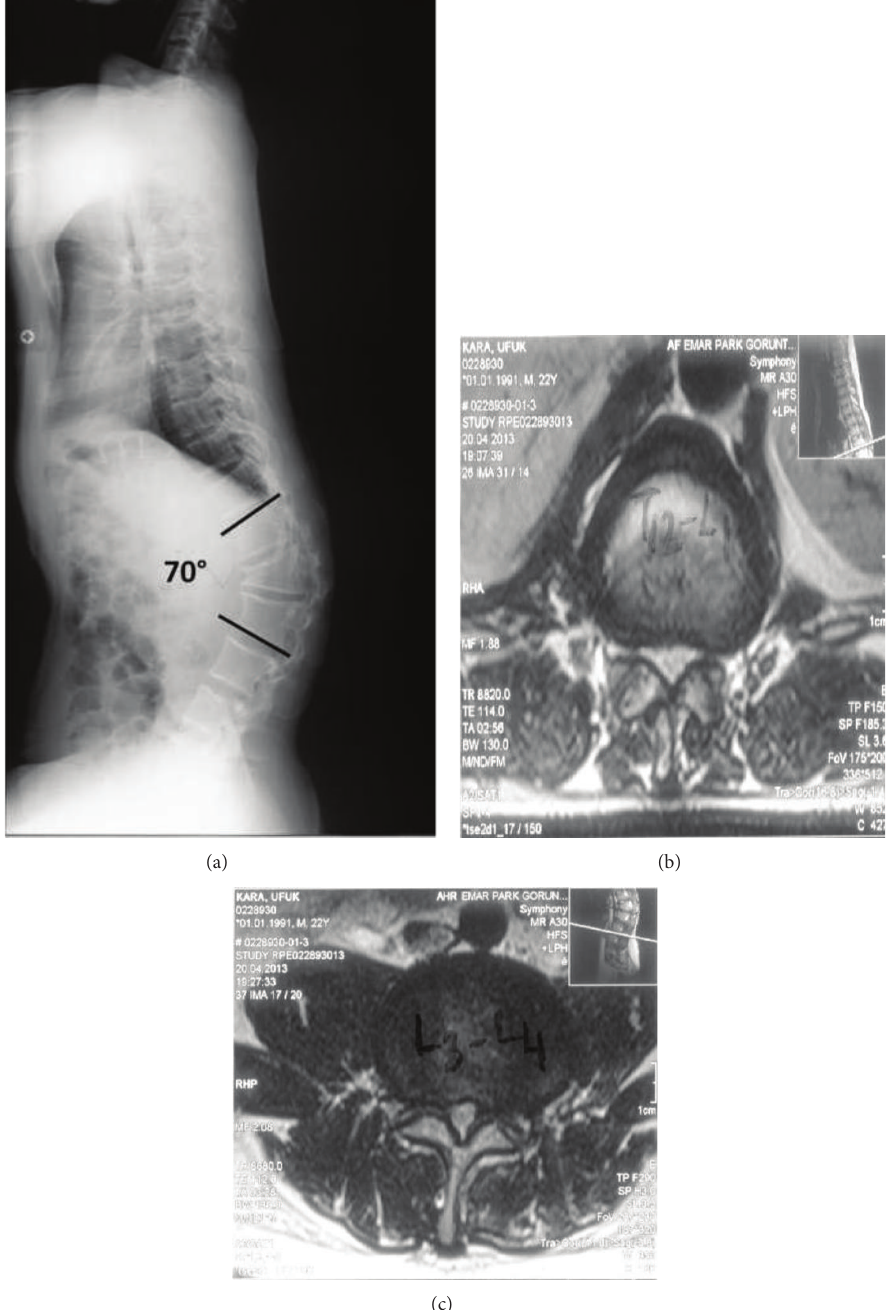
Figure 1: (a) Full spine X-ray showed an angular kyphosis with 70 degrees at the thoracolumbar area; (b)-(c) MRI studies showed a significant stenosis between levels T11 and L5 (MRI: magnetic resonance